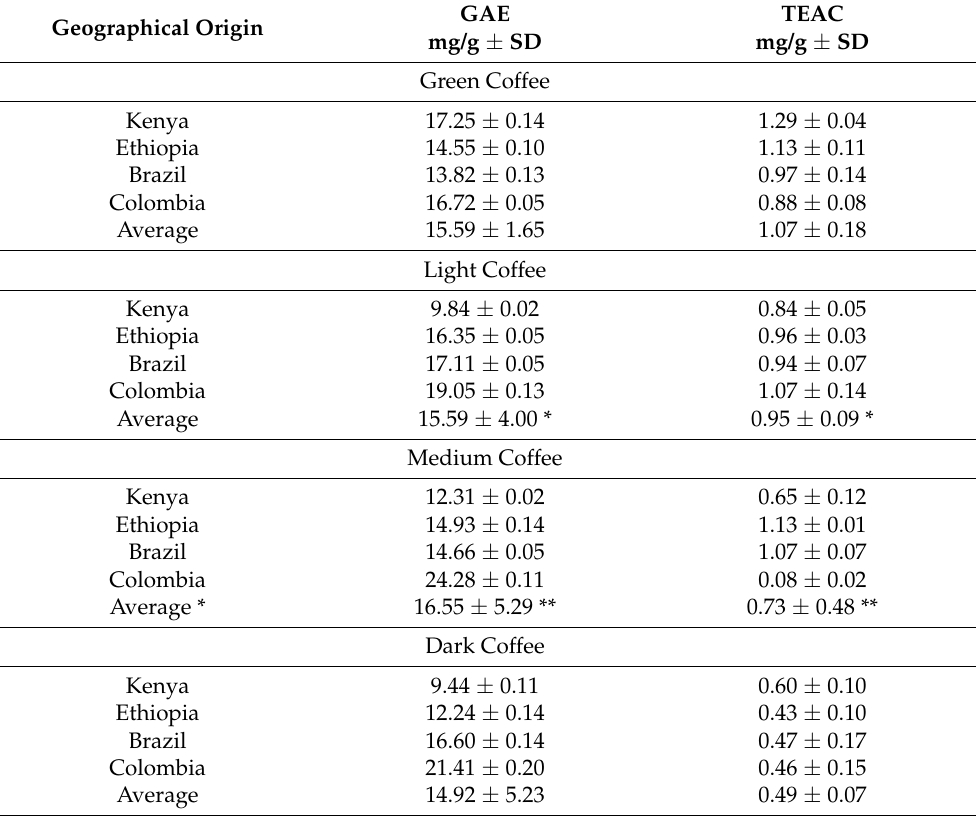
Table 1. Comparison of different roasting degrees for coffee samples from different geographical